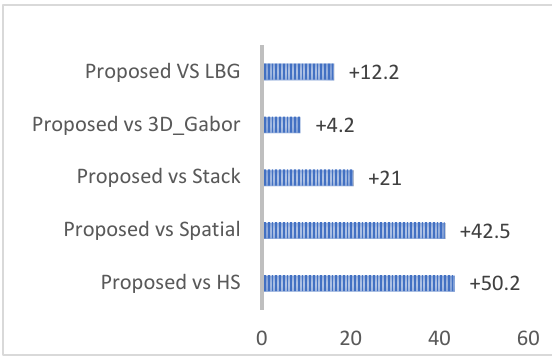
Figure 6. The McNemar test for proposed and other method According to Table II: As can be seen, the best result is related to the proposed method Also, As we expected, the use of spatial and spectral information simultaneously improved the conclusion.